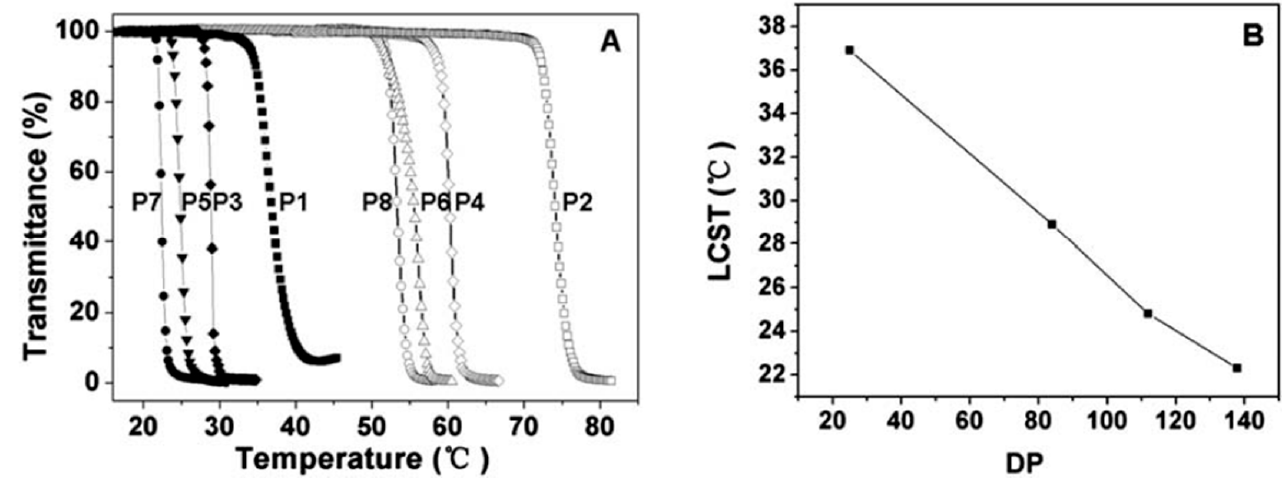
Figure 15. ( A ) Thermal phase transitions of P1 (PPLG 25 - g -MEO 2 ), P2 (PPLG 25 - g -MEO 3 ), P3 (PPLG 84 - g -MEO 2 ), P4 (PPLG 84 - g -MEO 3 ), P5 (PPLG 112 - g -MEO 2 ), P6 (PPLG 112 - g -MEO 3 ), P7 (PPLG 138 - g -MEO 2 ) and P8 (PPLG 138 - g -MEO 3 ), and the polymer concentration was 10 g/L. ( B ) The LCSTs of PPLG- g -MEO 2 as a function of the degree of polymerization. Reproduced with permission [37]. Copyright 2011, Royal Society of Chemistry.